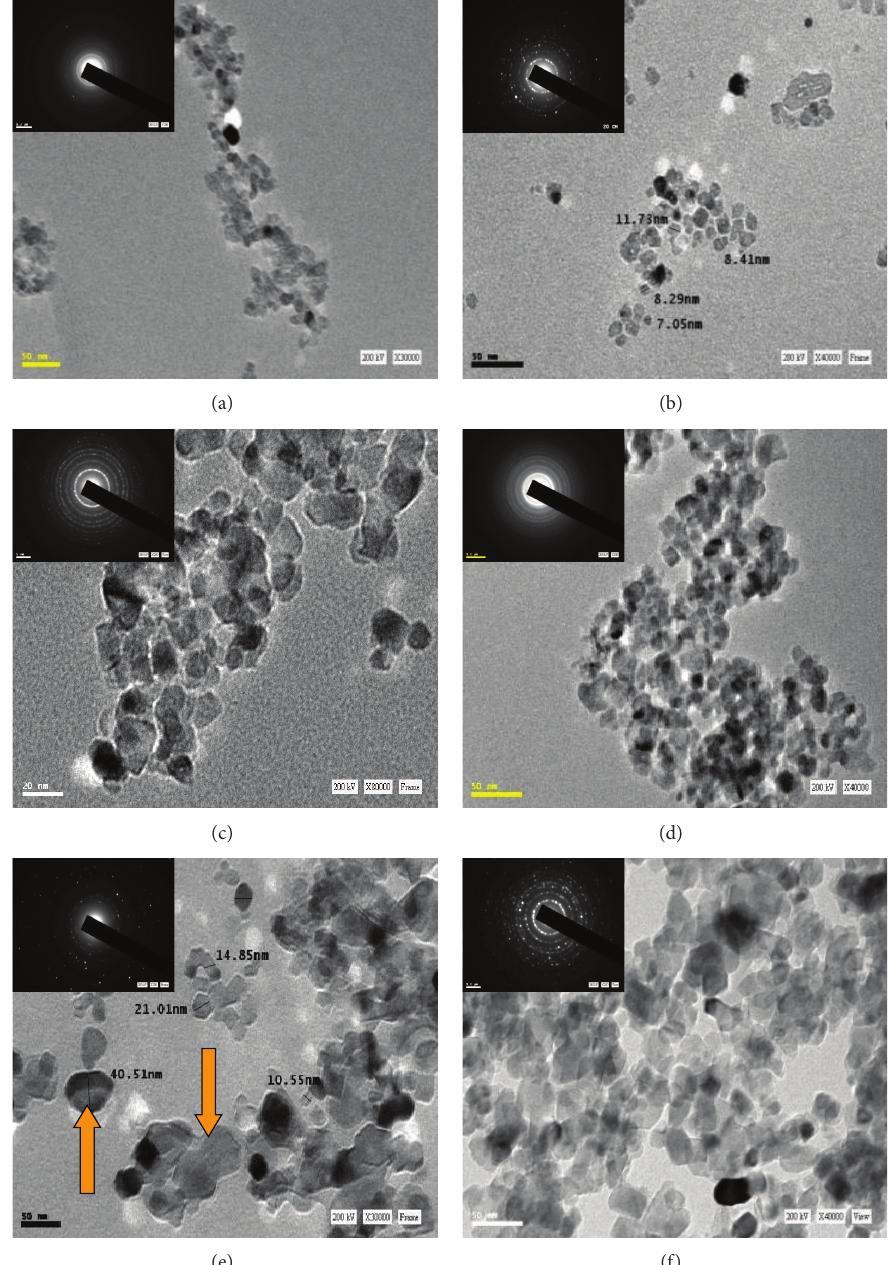
Figure 4: TEM images of the TiO 2 at different pH and different surfactants. (a) CTAB-A, (b) DBS-A, (c) NPE-A, (d) CTAB-B, (e) DBS-B, and (f)